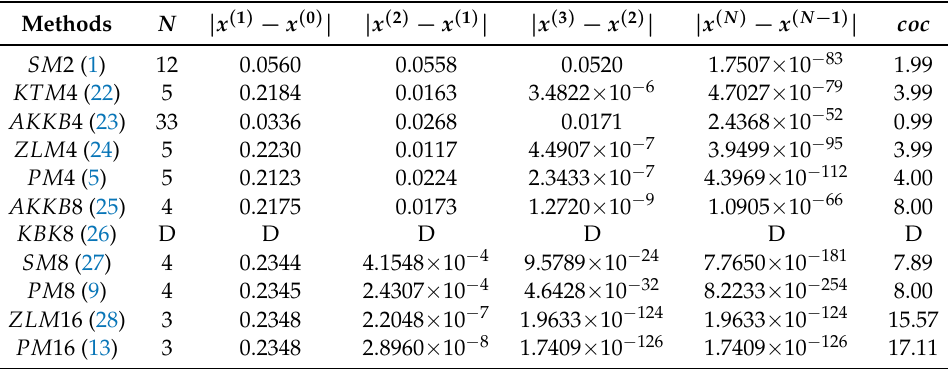
Table 2. Comparisons between different methods for f 2 ( x ) at x ( 0 ) =